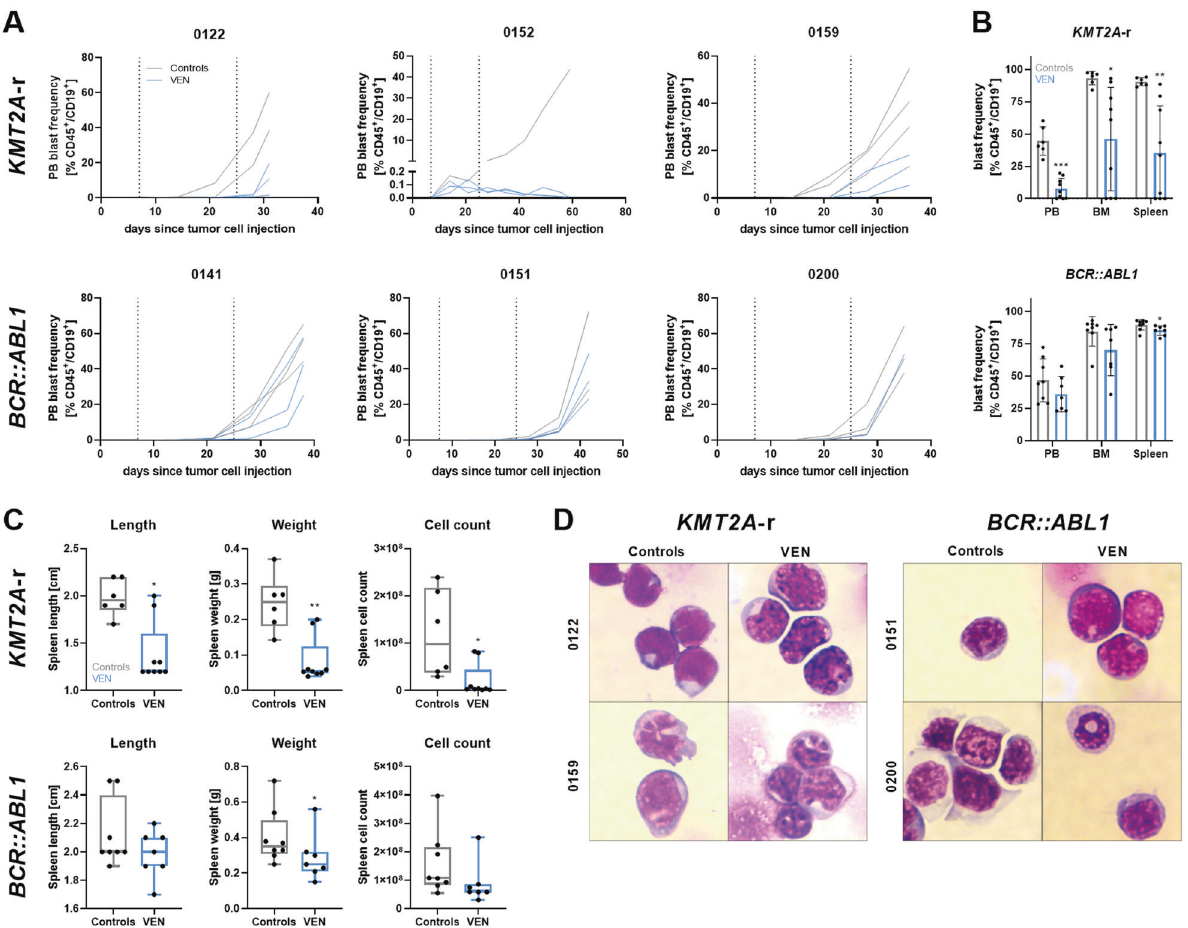
Fig. 7 Effects of VEN treatment in PDX models. Analysis of one to three individual animals per PDX model and intervention group. A Tumor cell proliferation of KMT2A (upper panel) and BCR::ABL1 rearranged models was monitored by peripheral blood (PB) blast frequency measurement via fl ow cytometry (CD45 + /CD19 + ). Each line represents an individual animal. Dotted lines represent the start and end date of the treatment interval. B Determination of blast frequency in PB, bone marrow (BM), and spleen by fl ow cytometry after experiment termination. Control and VEN-treated mice of all KMT2A (upper graph) or BCR::ABL1 rearranged models are summarized. Each dot represents an individual animal. Mean ± SD, unpaired t -test with Welch ’ s correction or Mann – Whitney test. C Box plots (min/max) of spleen length, weight, and cell count of KMT2A (upper panel) and BCR::ABL1 rearranged models. Controls and VEN-treated mice of all models per cytogenetic subtype are summarized. Each dot represents an individual animal. Mann – Whitney test. D Representative images of blast morphology of KMT2A